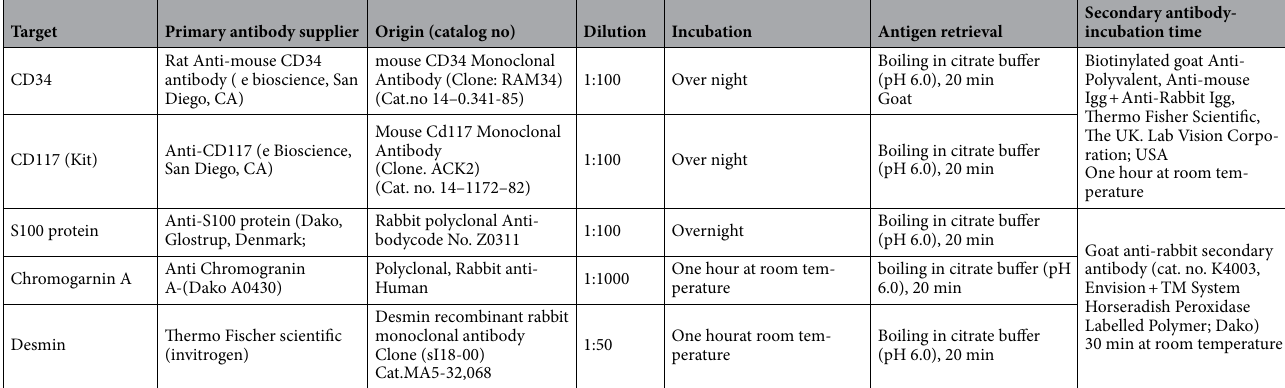
Table 2. Identity, sources, and working dilution of antibodies used in immunohistochemical studies. Antibodies used that showed reactivity in fish species in past